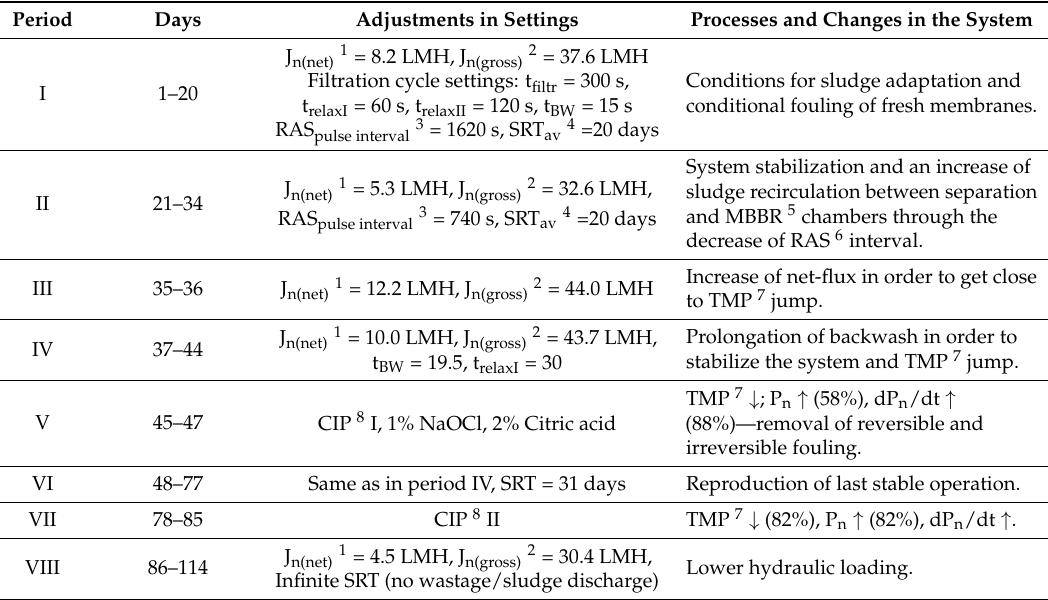
Table 2. BF-MBR pilot plant operation